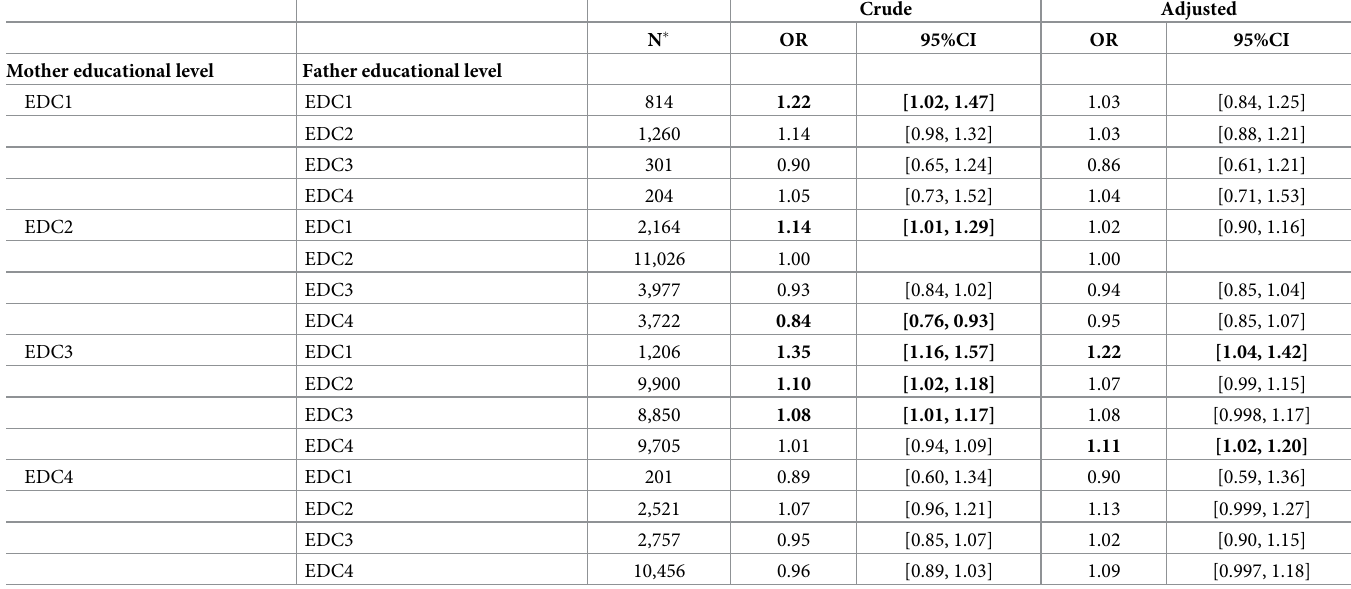
Table 4. Crude and adjusted odds ratios of the combination of mother’s and father’s educational level for wheezing in multilevel logistic regression analysis (multi- ple imputation, N =